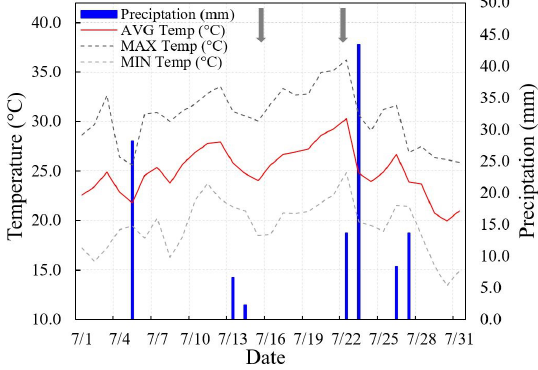
Figure 6. Daily average of temperature and precipitation during core stress experiment conducted in July